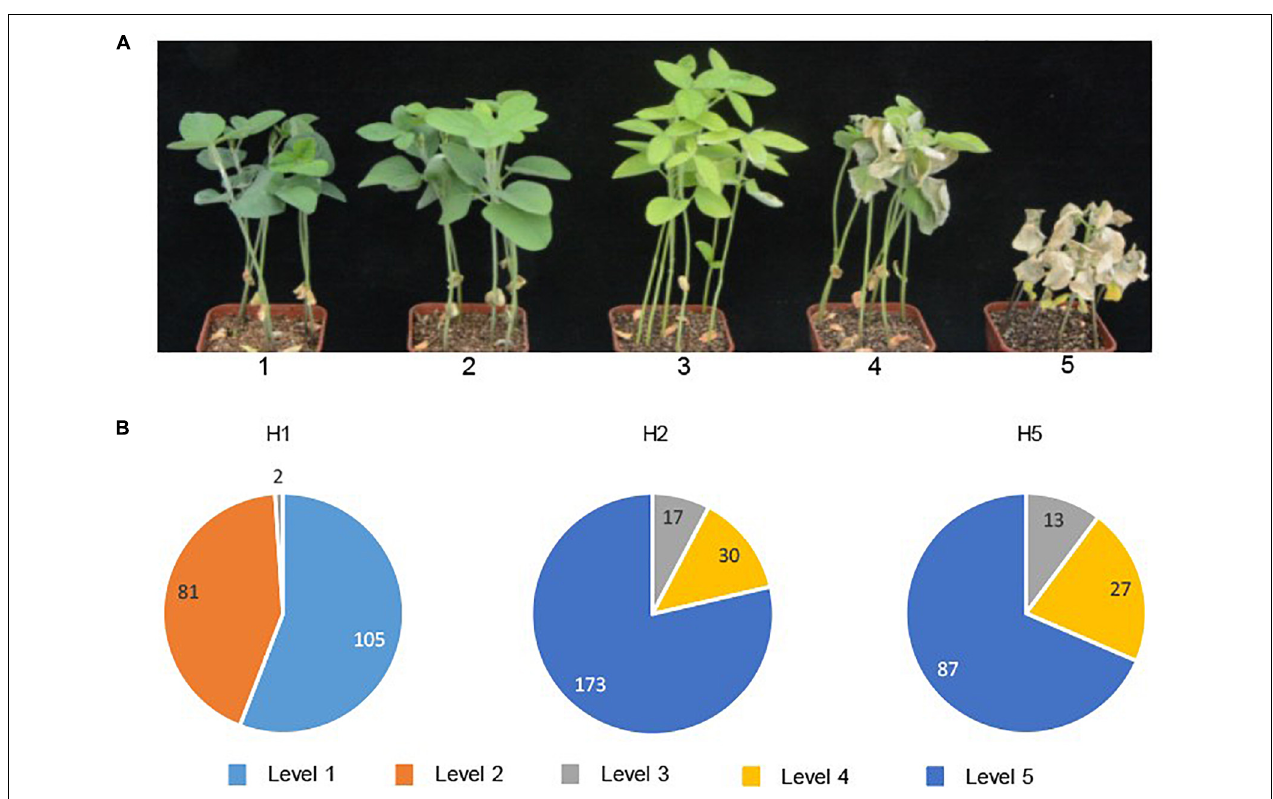
FIGURE 5 | Salt tolerance evaluation of 536 modern soybean breeding lines. Chlorosis scores were used for salt tolerance rating after 15 days of NaCl treatment (plants with score ratings 1 or 2 were considered salt tolerant; 3–5 were salt sensitive) (A) ; In each haplotype, the number of lines belonging to each chlorosis score for salt tolerance ratings (level 1 to level 5) are shown (B) .